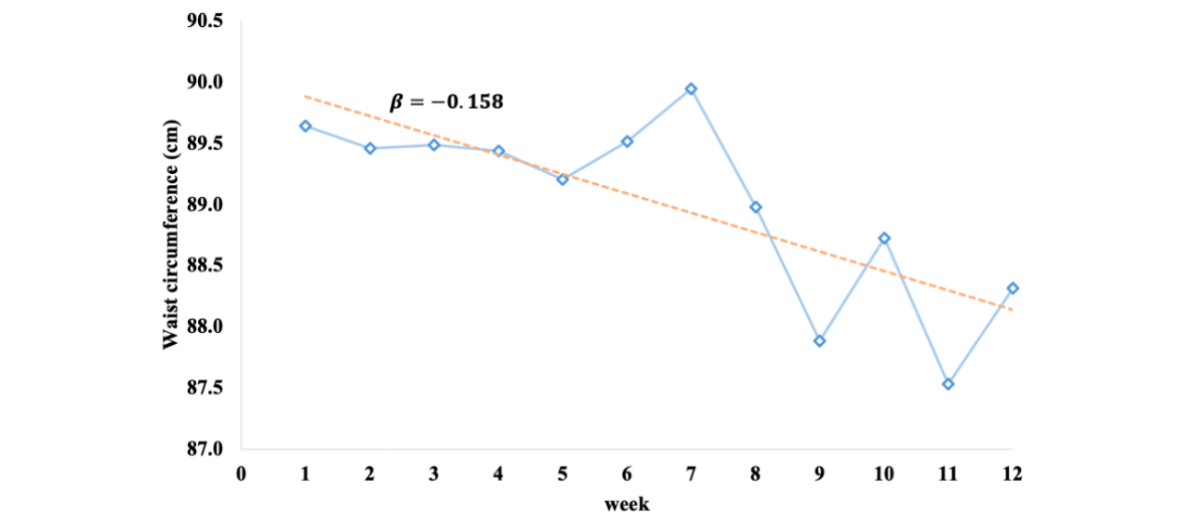
Figure 4. Trend of waist circumference by week. The blue solid line is the mean value of the waist size for each week; the orange line is a linear trend of the waist size by week.